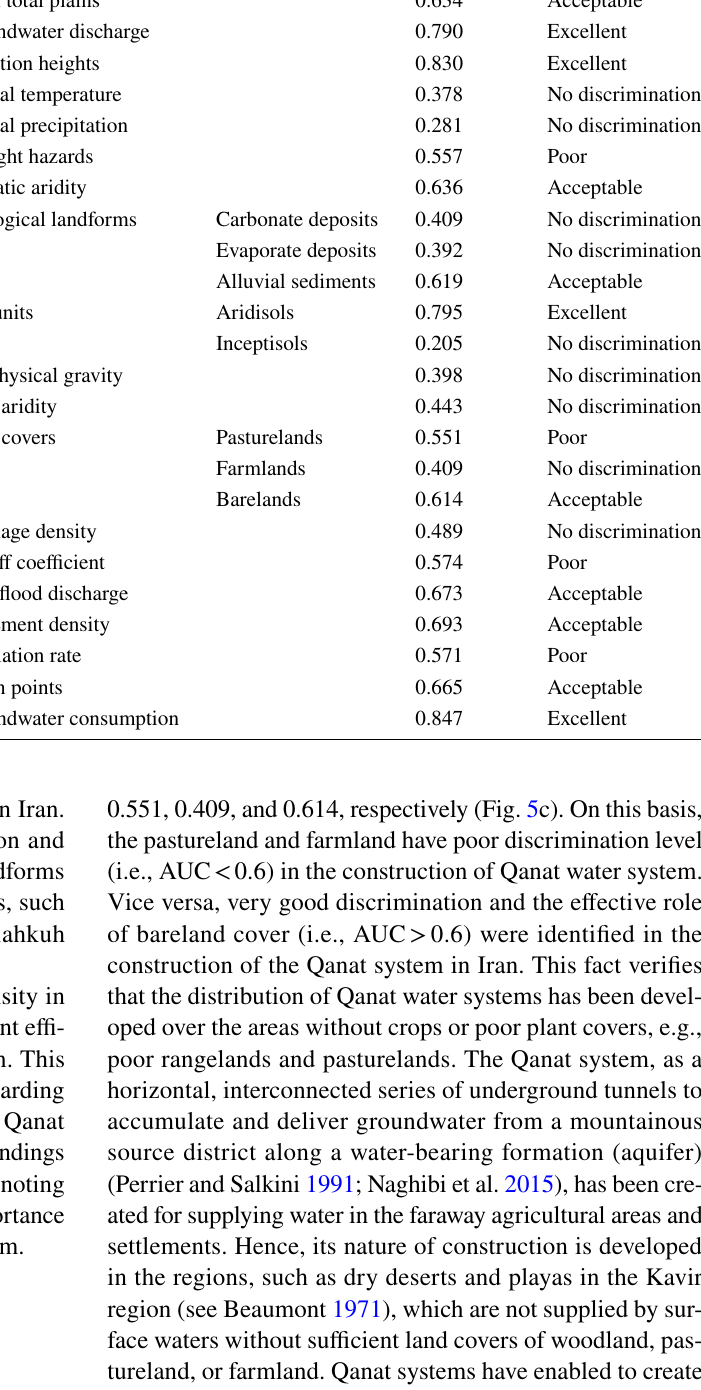
Table 9 Efficiency assessment of the environmental variables in the construction of the Qanat water system based on the AUC